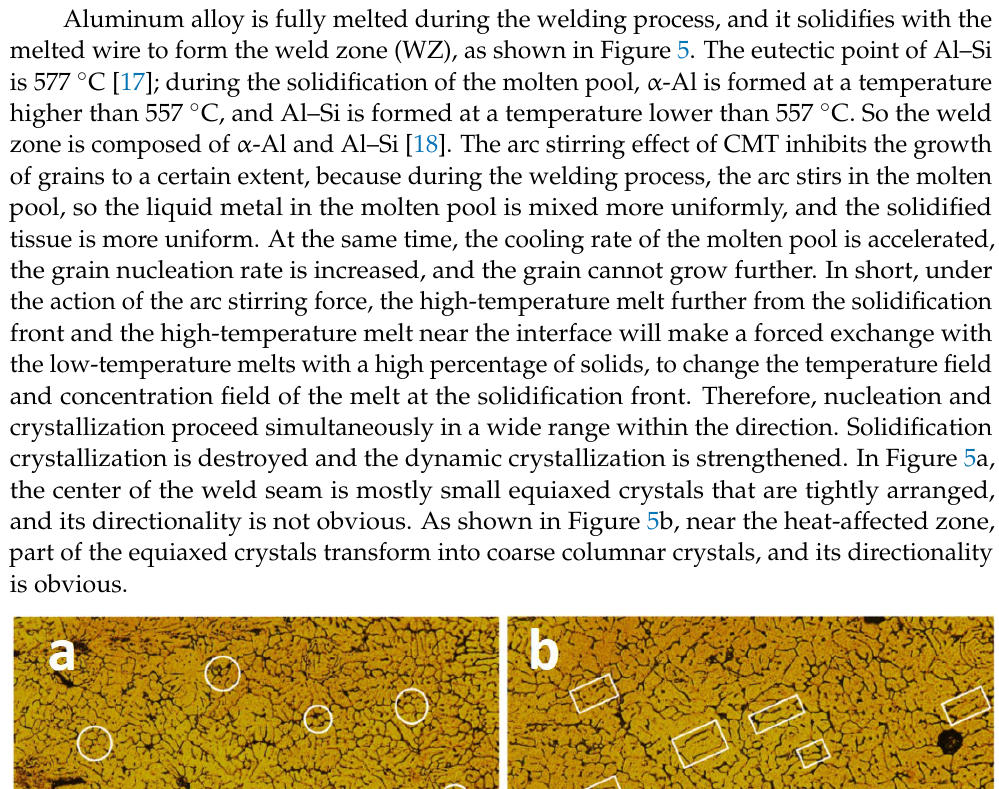
Figure 6. Microstructure of interface layer: ( a ) microstructure under 50 μm; ( b ) microstructure under 15 μm. The aluminum alloy and steel close to the welding seam have significant changes in organization and performance, and then become the welding heat-affected zone (HAZ). The heat-affected zone near the weld is heated higher, and the low-melting-point strengthening phase melts. In Figure 7a, the low-melting-point strengthening phase gath- ers at the grain boundary, and forms coarse equiaxed crystals after cooling and precipita- tion. At the junction of the weld zone and the heat-affected zone, there is an area with coarse grains and uneven structure; this is the fusion zone. The range of the fusion zone is extremely narrow; it is often called the fusion line. The heat-affected zone near the alu- minum alloy is less heated, and most of the columnar low-melting-point precipitation phase melts and agglomerates after cooling. As shown in Figure 7b, compared with the heat-affected zone close to the weld seam, the grain size of the heat-affected zone close to the aluminum alloy is significantly increased and become coarse columnar crystals. We can see the characteristics of competitive growth and epitaxial solidification.